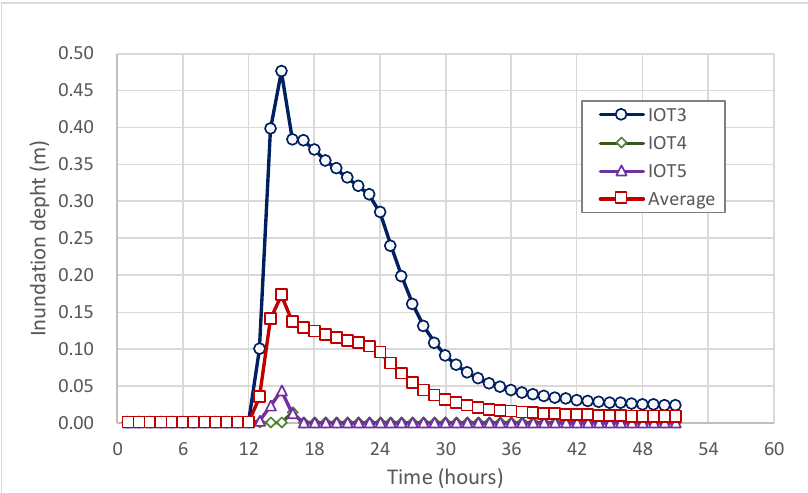
Figure 15. The SOBEK model simulated inundation-depth hydrographs at the IoT sensors for the 921st simulation case as the validated data.